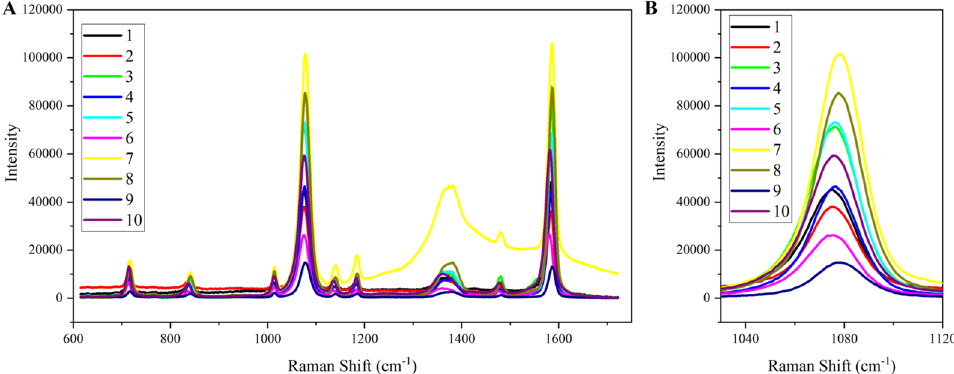
Figure 2. SERS characterization of different substrates wherein the AgNPs@MBA@SiO 2 has been placed. ( A ) SERS spectra and ( B ) zoomed spectra showing characteristic peak at 1075 cm −1 of AgNPs@MBA@SiO 2 on different materials: 1, semi-aniline leather; 2, aniline leather; 3, pigmented leather; 4, polyester; 5, silk; 6, plastic (PVC); 7, glass; 8, brass; 9, cotton; and 10, dyed pigmented leather.